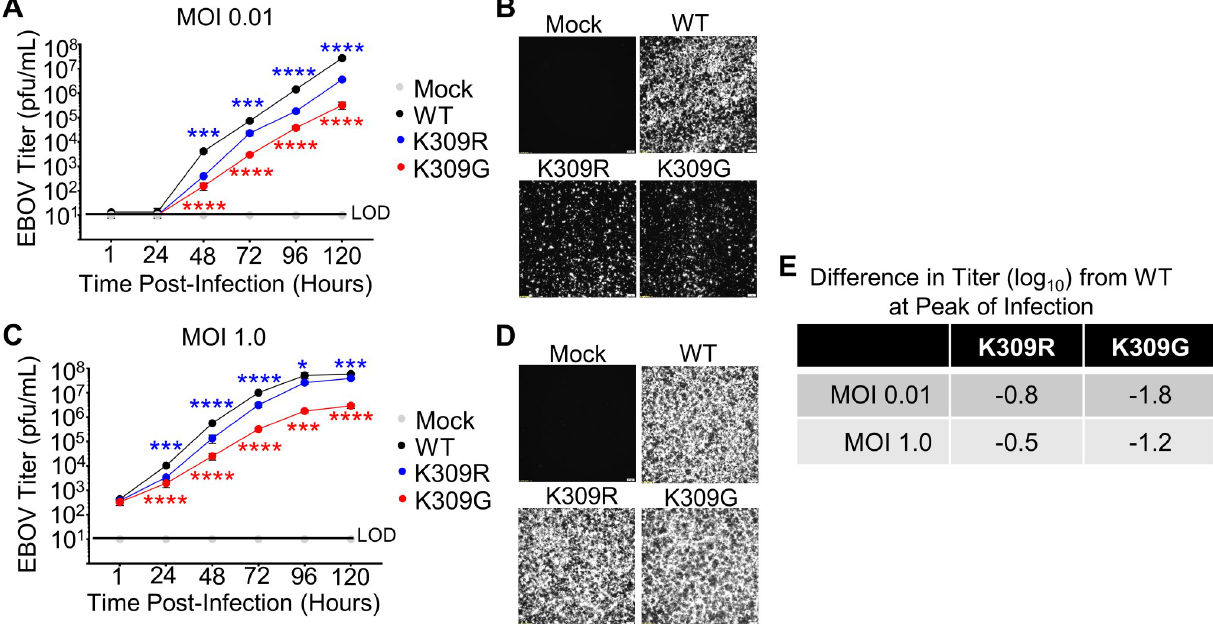
Fig 4. The replication of rEBOV-VP35/K309R and -G mutants is attenuated in IFN-incompetent cells. VeroE6 cells were mock infected (grey) or infected with rEBOV-eGFP-VP35/wt (black), -K309R (blue), or -K309G (red) viruses at an MOI of 0.01 ( A-B ) or 1.0 PFU/cell ( C-D ). The fluorescence microscopy images (GFP) are representative of the three images taken ( B and D ). The limit of detection (LOD), 10 PFU/mL, is indicted ( A and C ). ( E ) The difference in titer (log 10 ) between the mutant and wt viruses at the time point corresponding to the wt peak titer is summarized. The titrations were collected in biological triplicate ( A, C ). The data analysis was done using a two-way ANOVA ( A and B ) with Bonferonni’s post-test for comparison between groups. P-value: � < 0.05, ��� < 0.001, ���� < 0.0001. Red and blue stars represent K309G and K309R comparison to wt, respectively. Non- significant differences, P-value > 0.05, are not indicated to prevent cluttering on the image.